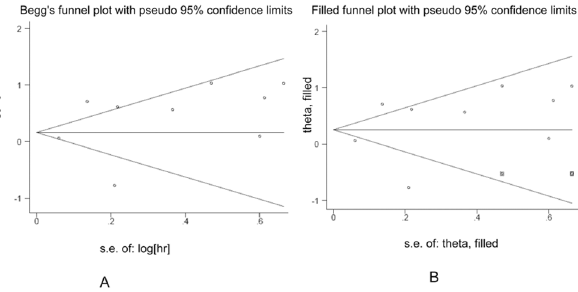
Fig 6. Funnel plots in the context of DFS without and with trim and fill. The pseudo 95% CI is computed as part of the analysis that produces the funnel plot, and corresponds to the expected 95% CI for a given SE.